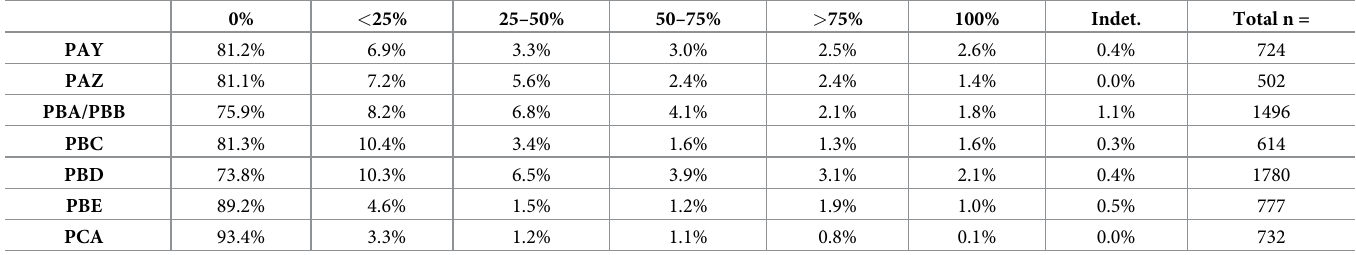
Table 3. Percentage of cortex on flakes and blades per